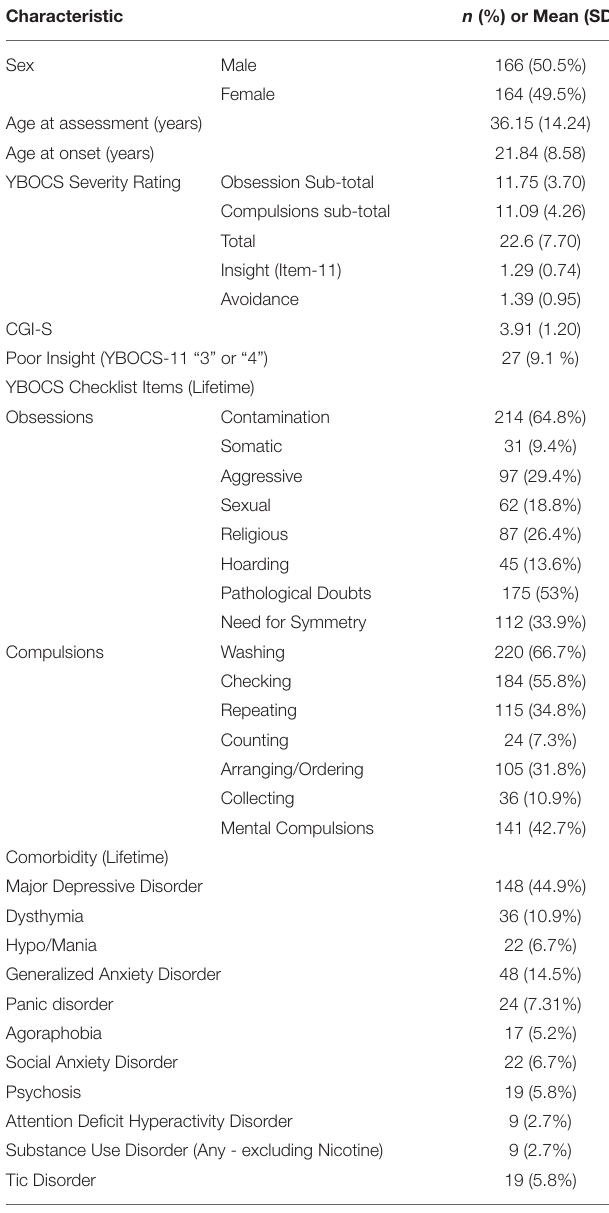
TABLE 2 | Clinical characteristics of the sample ( N =